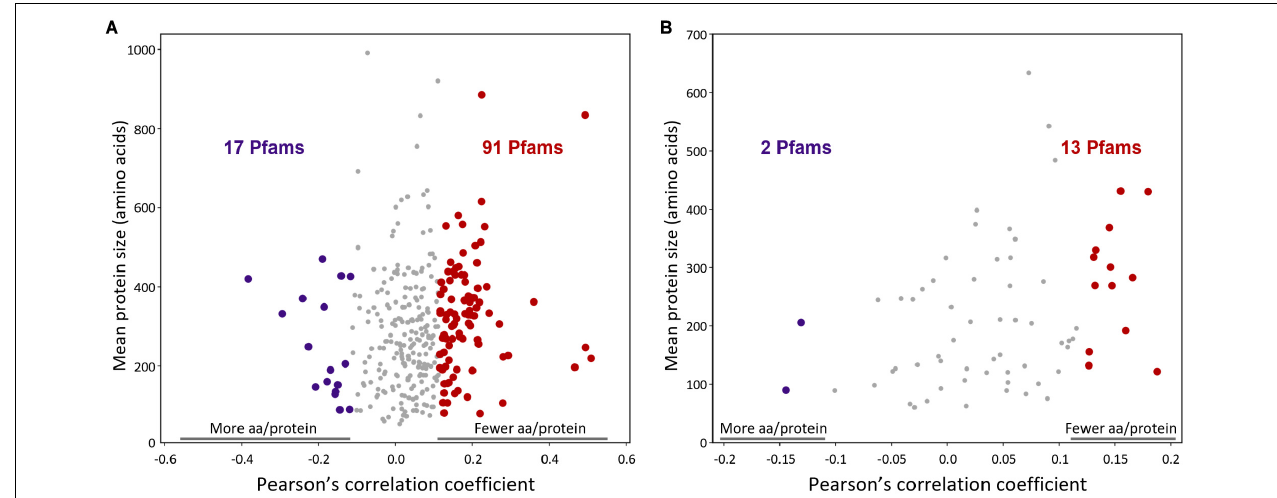
FIGURE 6 | Protein size vs. pH correlations for conserved Pfams. (A) Pfams present in over 90% of species and in a pH span of at least 6 pH units were selected for analysis. For each Pfam, the Pearson’s correlation coefficient for protein size vs. organism optimal growth pH was calculated using the species averages as data. Each point corresponds to a different Pfam. Positive correlations (91 red points to the right) indicate Pfams whose proteins are shorter at low pH, while negative correlations (17 purple points to the left) are Pfams whose proteins are larger at low pH. The 25 Pfams with the lowest p -values are listed in Supplementary Table 4 . (B) Analog to (A) but for a list of Pfams that in addition to being present in over 90% of the species and in a span of at least 6 pH units were also in a unique copy in the genomes (proteins with the Pfam per genome < 1.1), and only one domain architecture was dominant in the proteins. These Pfams are listed in Supplementary Table 5 . For both plots, a false discovery rate q -value of 0.05 was used for statistical significance. Significant correlations are shown as big points, which are red for positive correlations and purple for negative correlations. Non-significant correlations are shown as small gray